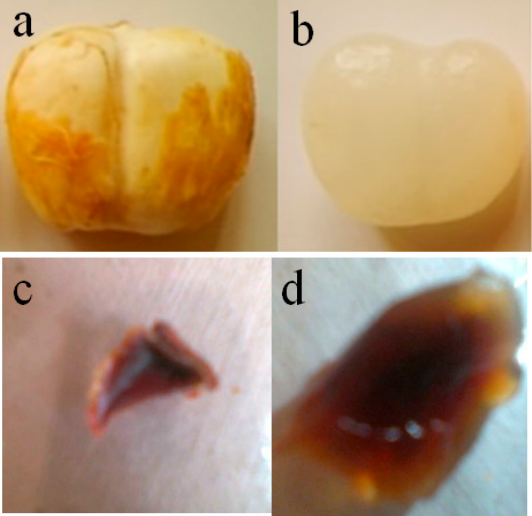
Figure 1. Digital photographs of ( a ) PPK fruit, ( b ) PPK after seed removal, ( c ) dry PPK hydrogel, and ( d ) swollen PPK hydrogel (photographs were captured using Nikon-D5200, Japan Optical Industries Co., Ltd.).